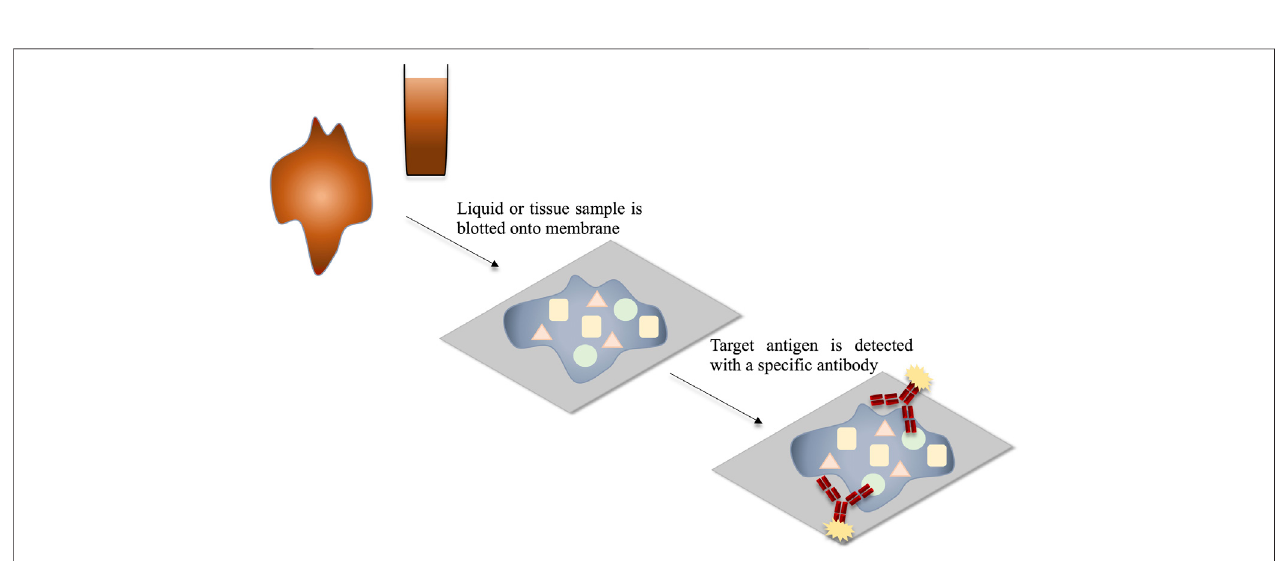
FIGURE 7| Schematic representation of the detection ofviral antigens through dot blot or tissue blot. The mixture ofantigens within the sample isblotted onto the membrane and thereby immobilised. The target antigens are detected using target-speci fi c labelled antibodies.